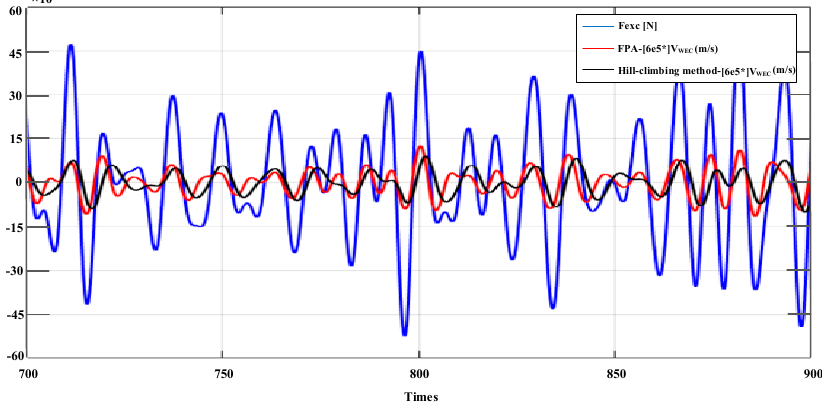
Figure 9. Simulated excitation force and the velocity of the buoy.